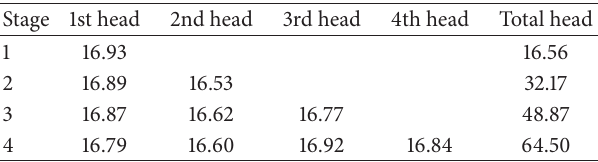
Table 4: Head at design flow contrast of different stages